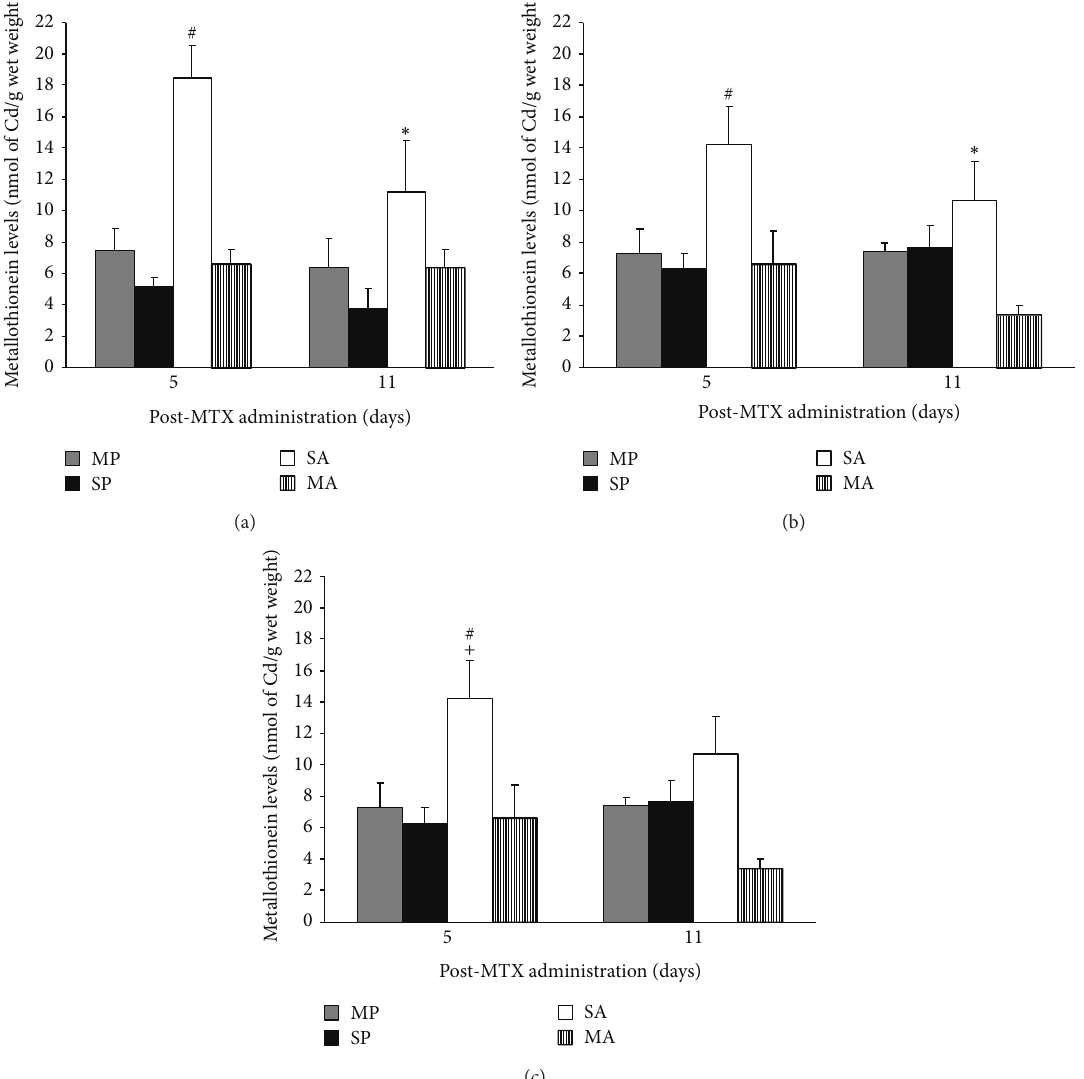
Figure 3: MT levels (nmol Cd bound/g wet weight) in the duodenum (a), jejunum (b), and ileum (c) of C57BL/6 mice treated with PS, PM, AS, and MA ( 𝑛 = 8 /group). # indicates significant differences ( 𝑃 < 0.01 ) compared to all other groups on d 5. ∗ denotes significance ( 𝑃 < 0.05 ) compared to AS on d 11. + indicates significance ( 𝑃 = 0.03 ) compared to d 5 and d 11 in PM